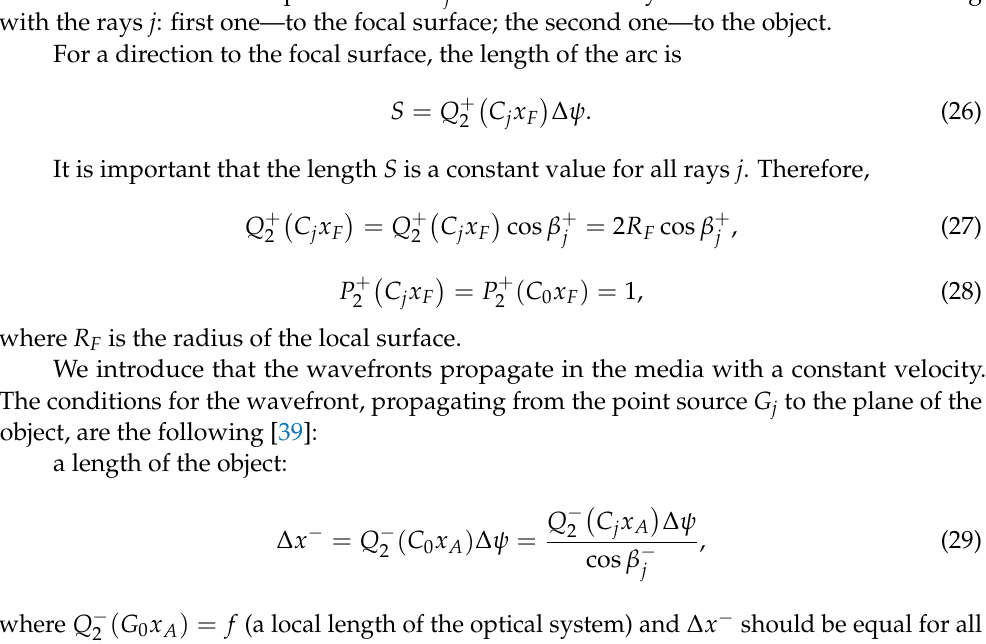
Figure 7. Homeomorphic imaging of an ideal microscope system.